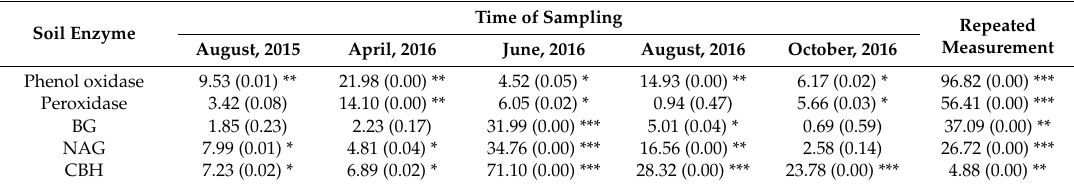
Table 4. F-values and p-values (in parentheses) for significance tests of the effects in different thinning treatments on soil enzyme variables